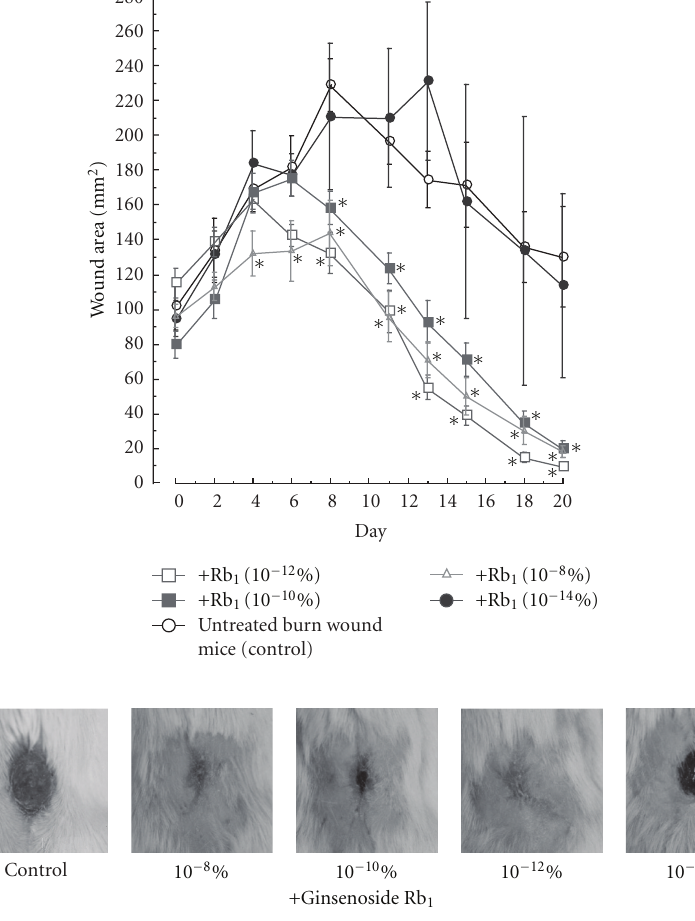
Figure 2: E ff ects of ginsenoside Rb 1 on wound healing in mice [26]. After the burn wound was made by applying a customized soldering iron to the skin on the backs of male Balb/c mice (6 weeks old) for 10 s at 250 ◦ C, a sterile biopsy punch (8mm diameter) was used to excise